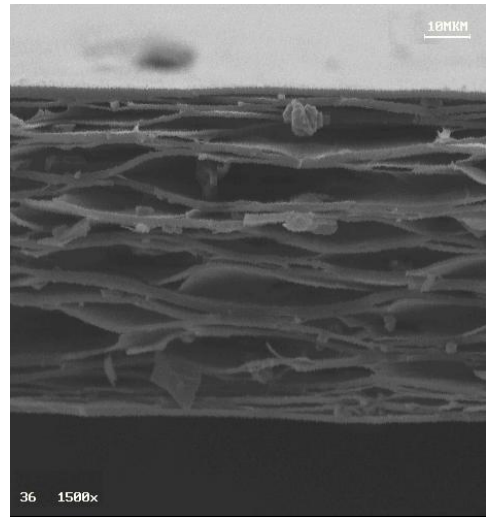
Figure 4. SEM image of the polypropylene ferroelectret